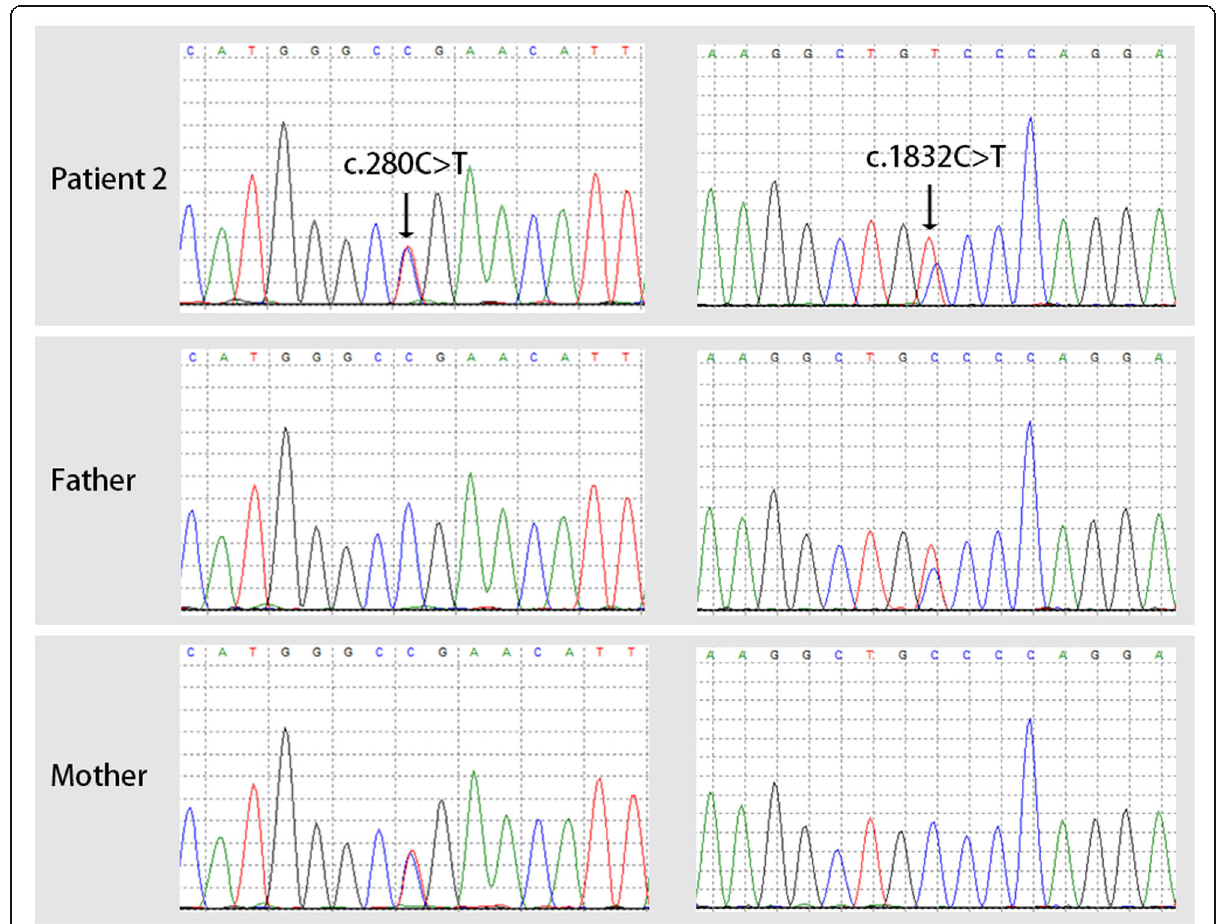
Fig. 2 Sanger sequencing validation of the PYGL gene mutations. The arrows show the compound heterozygous mutations of patient